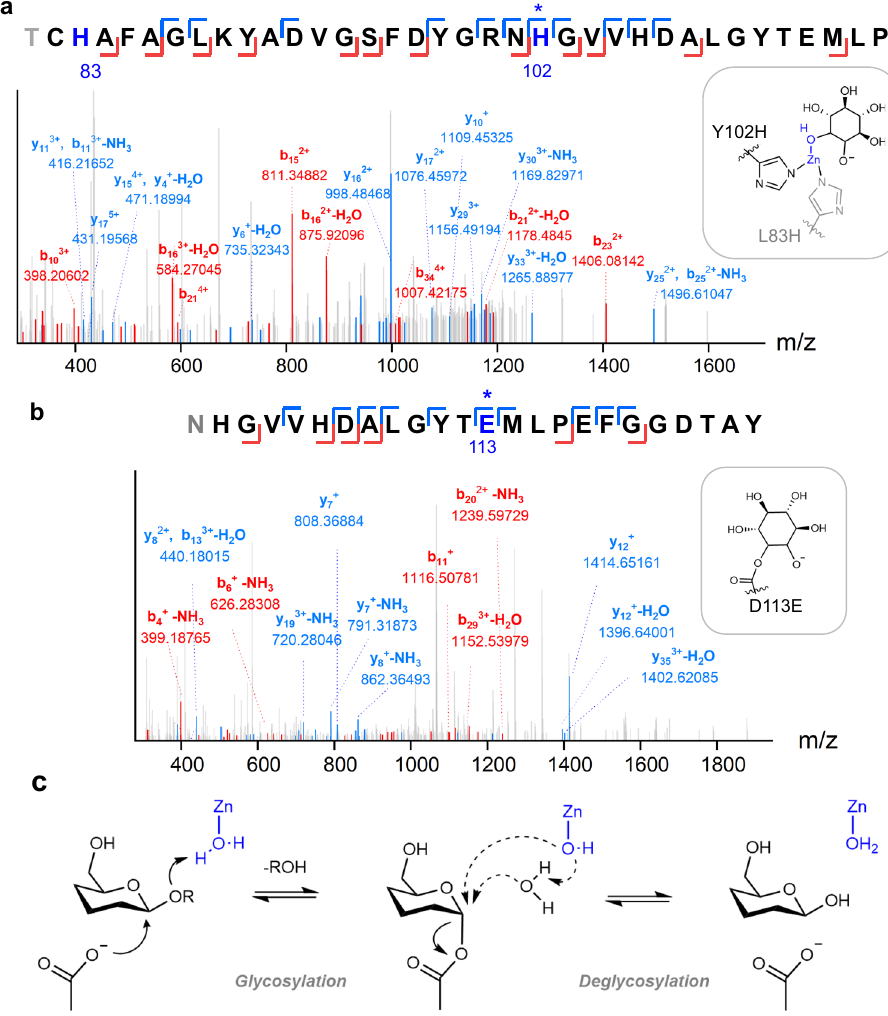
Fig. 5 | Mechanistic studies of OmpF2/E-R2 variant. The representative tandem LC/MS mass fragmentations after treating with CBE inhibitor with a Zn-bound and b apoproteins.Onlymajorpeaksarelabeledforclarity.Theproposedstructuresof